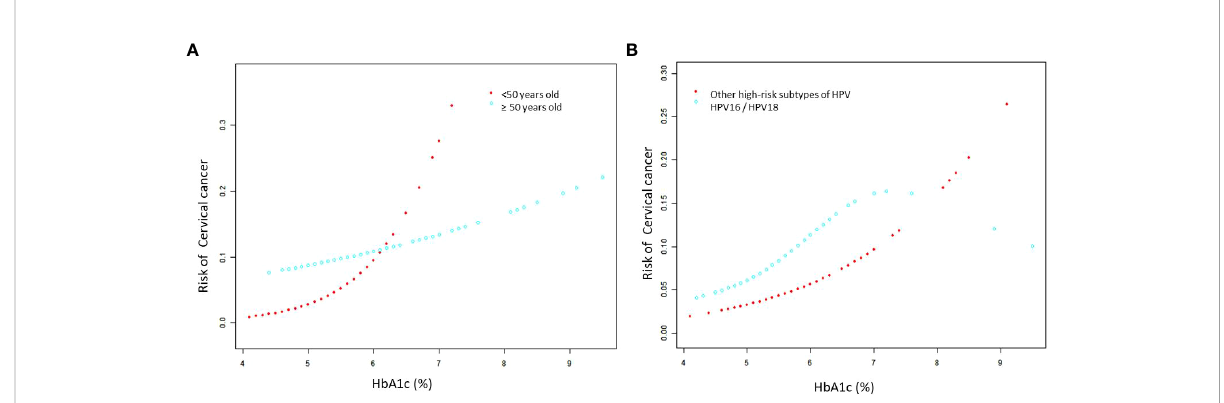
FIGURE 3 The association for subgroup analysis between HbA1c and cervical cancer. (A) Smooth fi tting curve strati fi ed by age, adjusted for adverse maternal history, vaginitis, and type of HPV infection. (B) Smooth fi tting curve strati fi ed by type of HPV infection, adjusted for age, adverse maternal history and vaginitis.The red line represents the fi tted curve of HbA1c and cervical cancer, and the blue line represents the 95% con fi dence interval of the